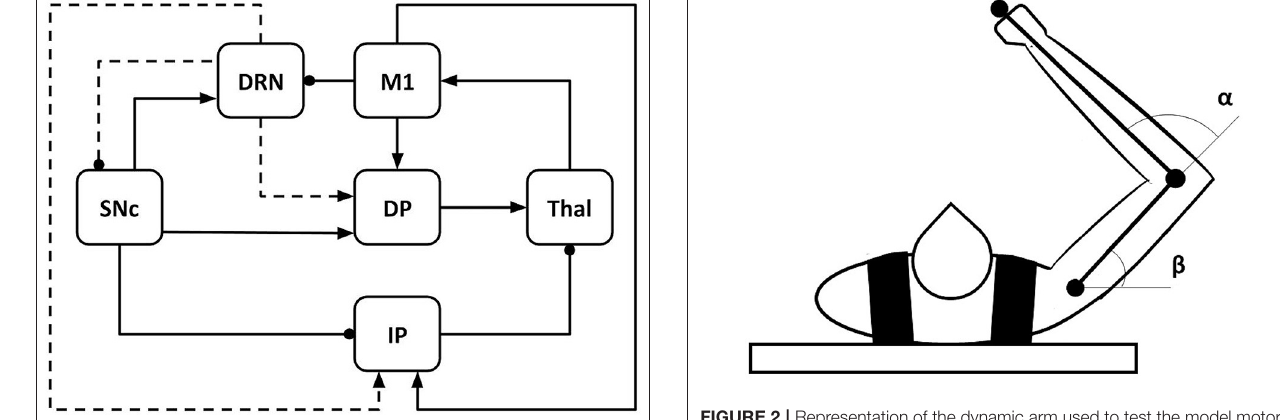
FIGURE 2 | Representation of the dynamic arm used to test the model motor behavior. The task space is a horizontal plane in which the arm is free to move according to the inputs received from